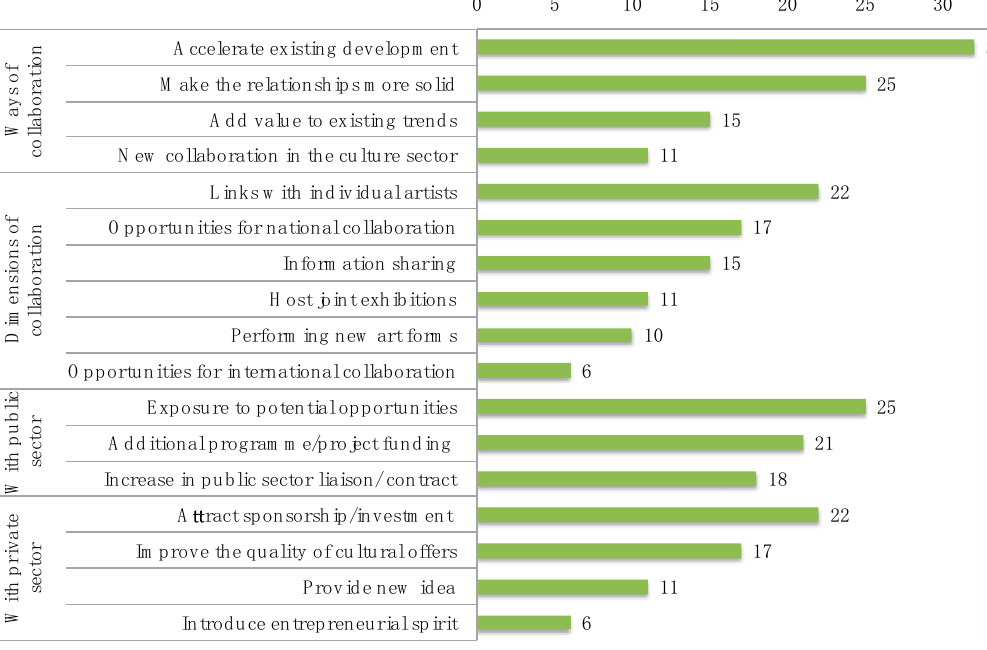
Figure 1. Perceptions of cultural sector about the cultural network effects of Liverpool 2008. Note: This is the 2014 cultural sector survey; number = frequencies of responses (n= 42).